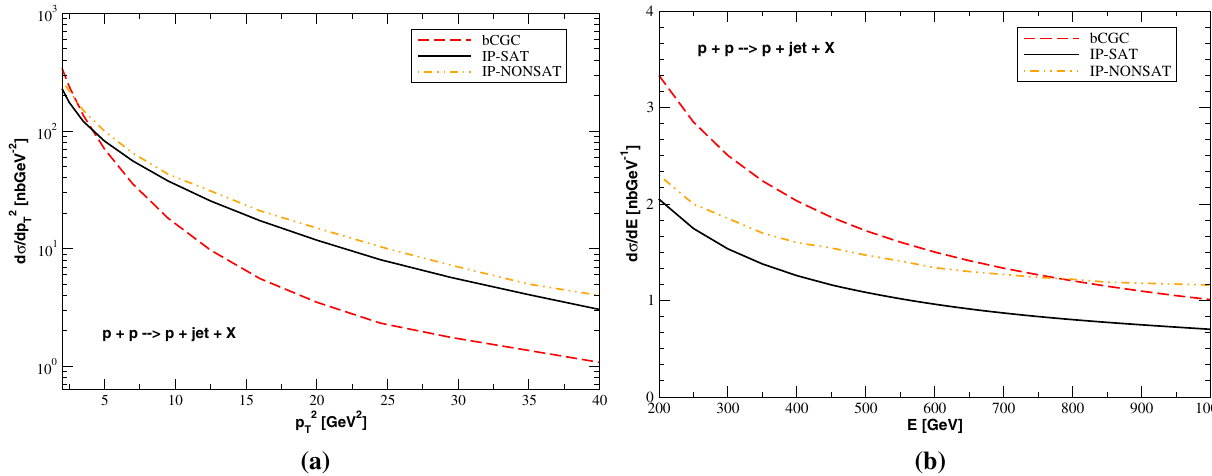
Fig. 4 Predictions for the a transverse momentum distribution and b energy spectrum for the single inclusive jet photoproduction at very forward √ s = 13 rapidties in pp collisions at